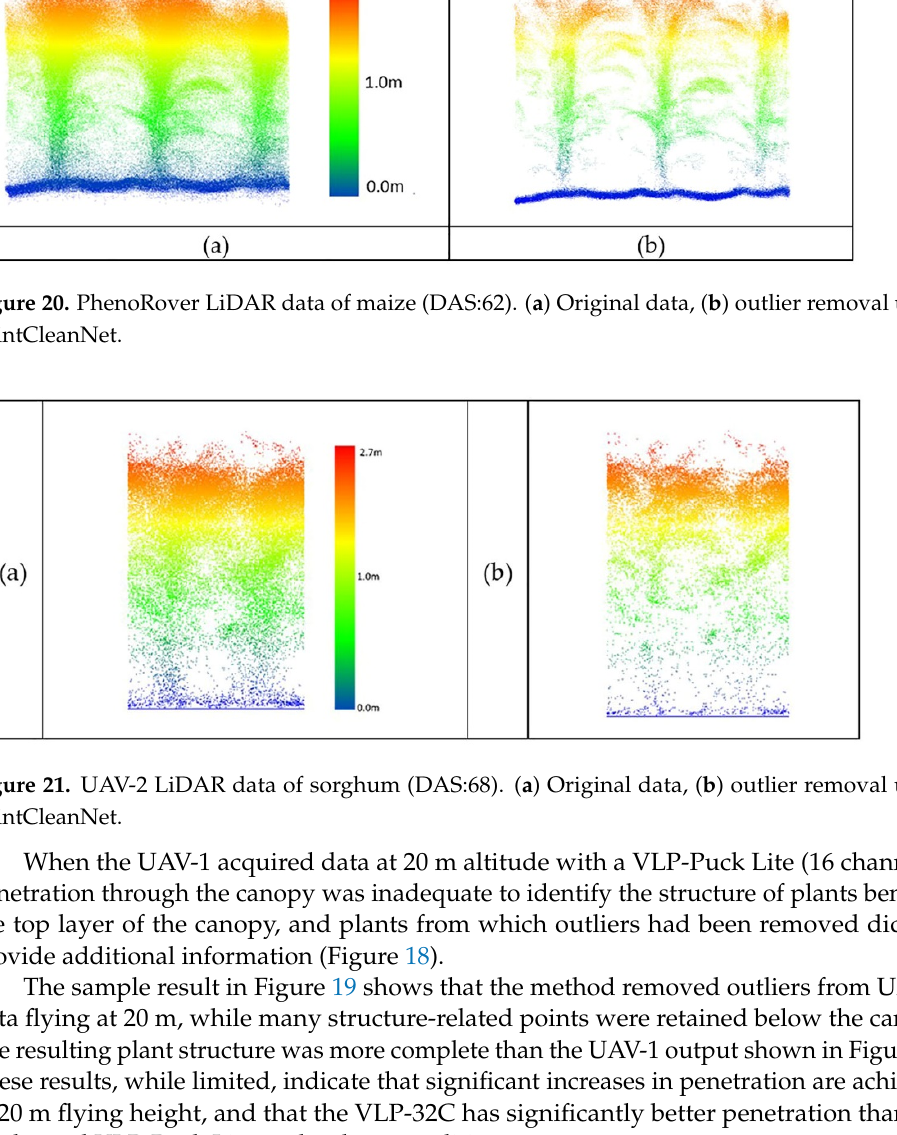
18 of 24 Figure 19. Data from UAV-2 at the altitude of 20 m over maize (DAS: 60). ( a ) Original point cloud perpendicular to the direction of the rows; ( b ) results of outlier removal using PointCleanNet. While the PhenoRover point cloud data were more dense, there were additional